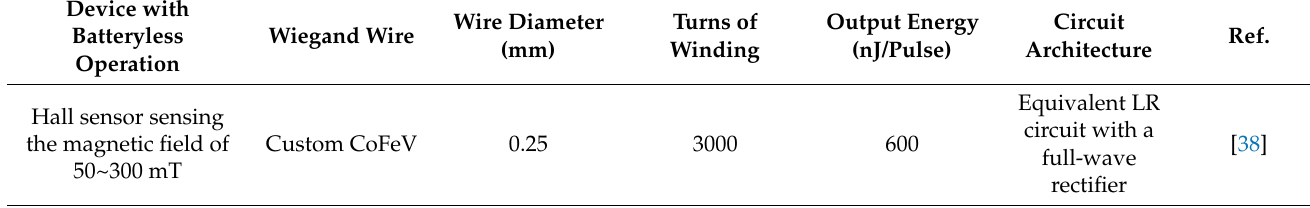
Table 2. Application scenarios for batteryless devices powered through the Wiegand